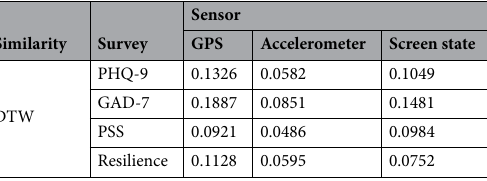
Table 2. τ = 1 (hourly resolution), temporal rule = “day of week”; Pearson correlation coefficients.